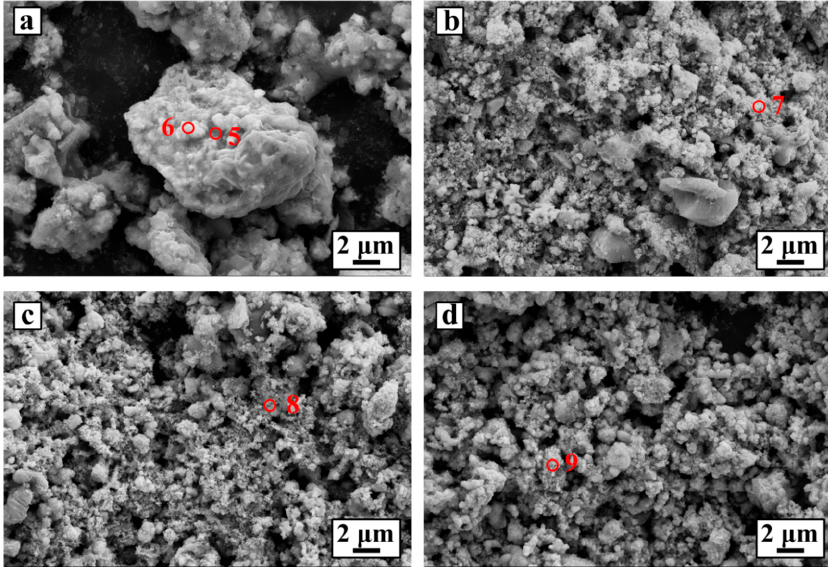
Figure 3. SEM images of the samples electrochemically reduced for ( a ) 2 h; ( b ) 4 h; ( c ) 6 h and ( d ) 8 h under 3.0 V at 900 °C. Table 2. EDS analyses of Point 5 and Point 6 marked in Figure 3a; Point 7 marked in Figure 3b; Point 8 marked in Figure 3c and Point 9 marked in Figure 3d.